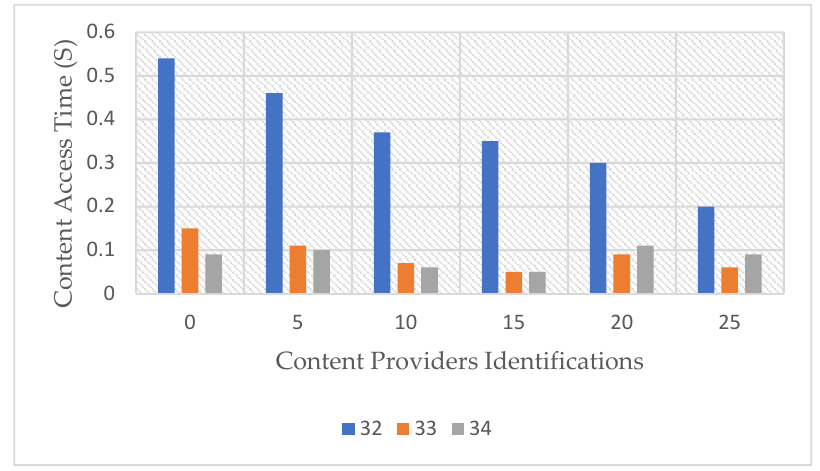
Figure 12. Impact of popular content in caching.